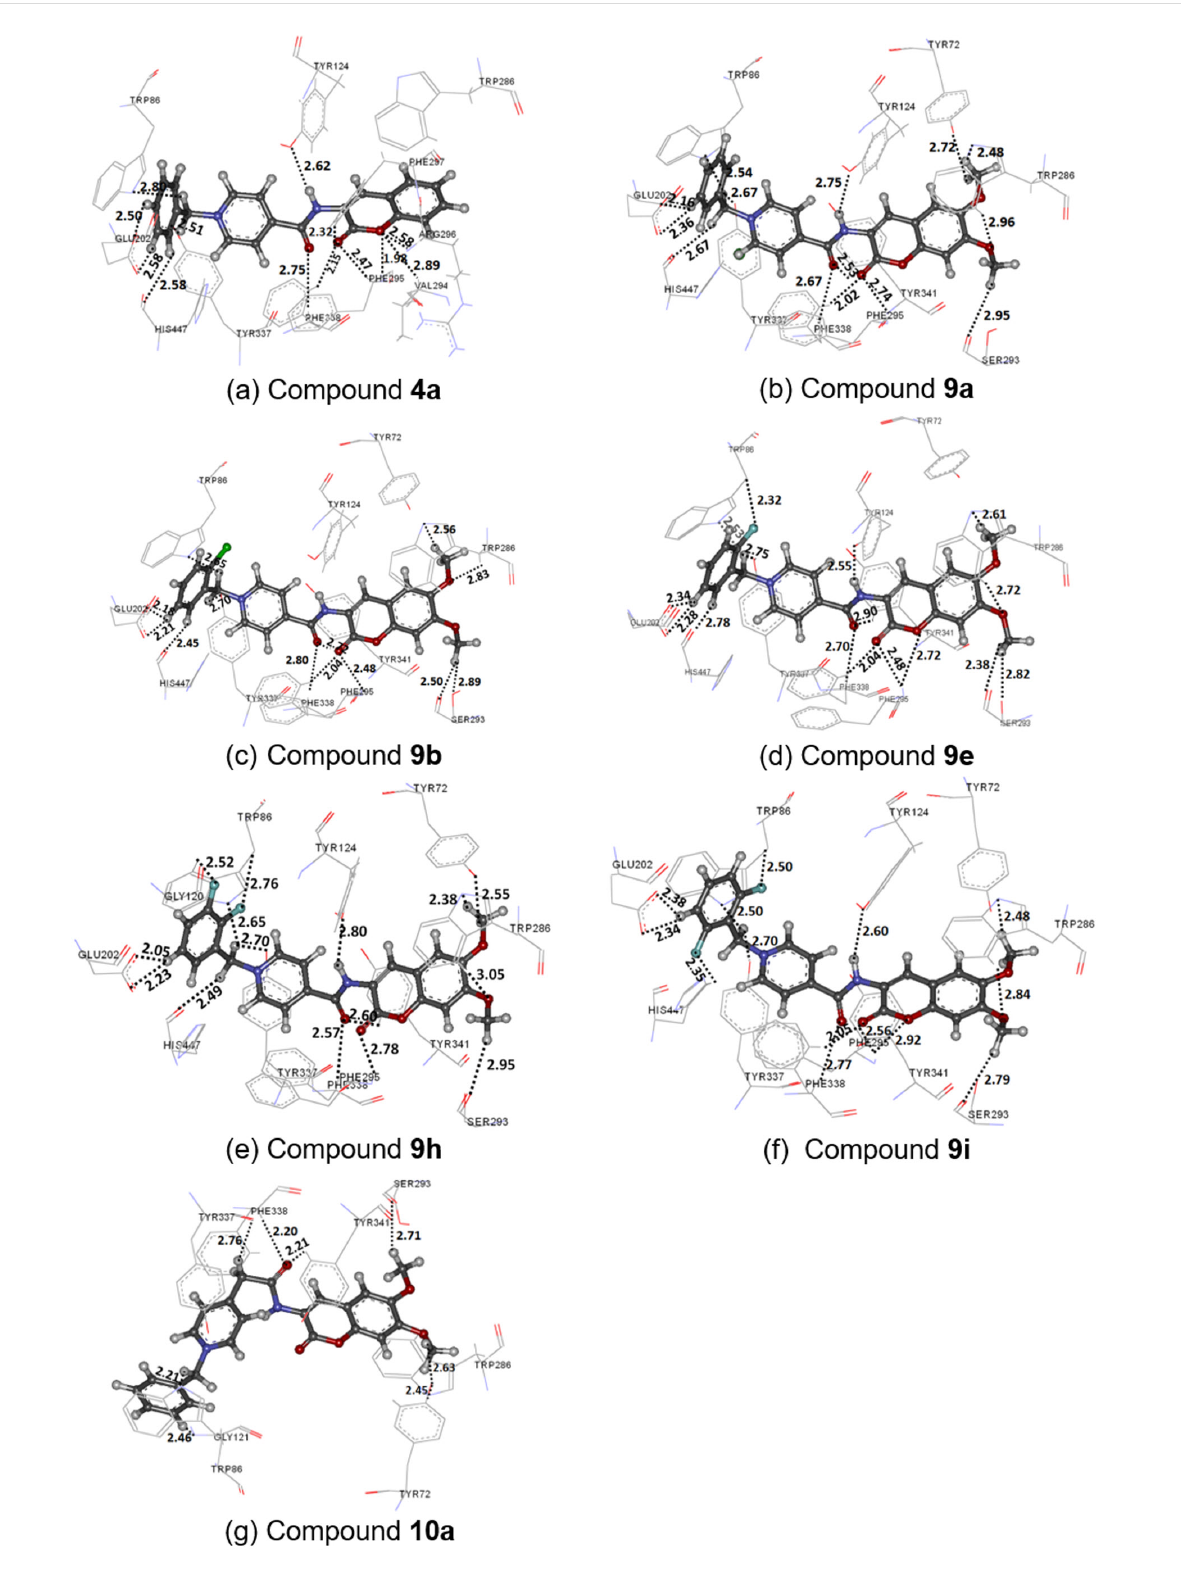
Figure 3: Binding interactions in the rhAChE binding pocket with (a) 4a , (b) 9a , (c) 9b , (d) 9e , (e) 9h , (f) 9i , and (g) 10a . Distances are shown in angstrom